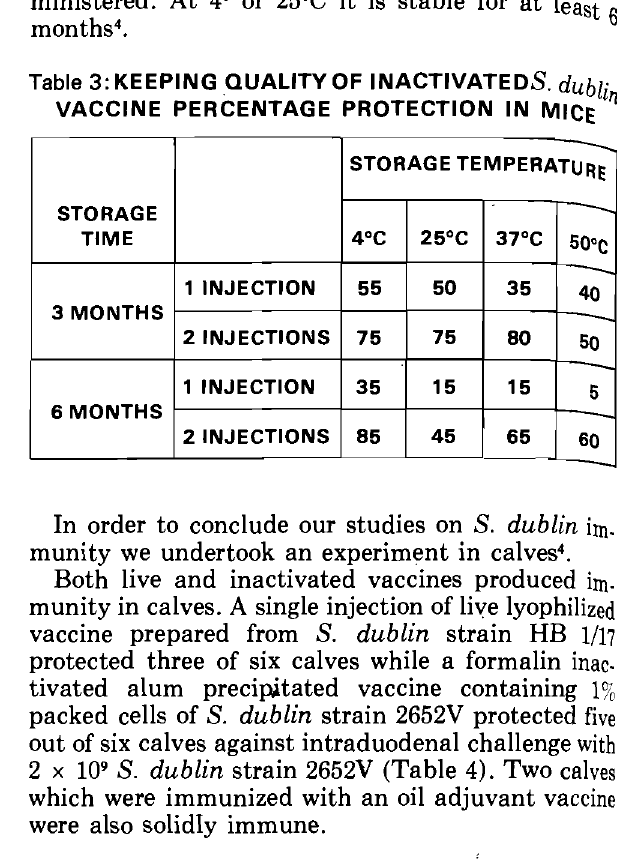
Table 3: KEEPING QUALITY OF INACTIVATEDS. dUbli